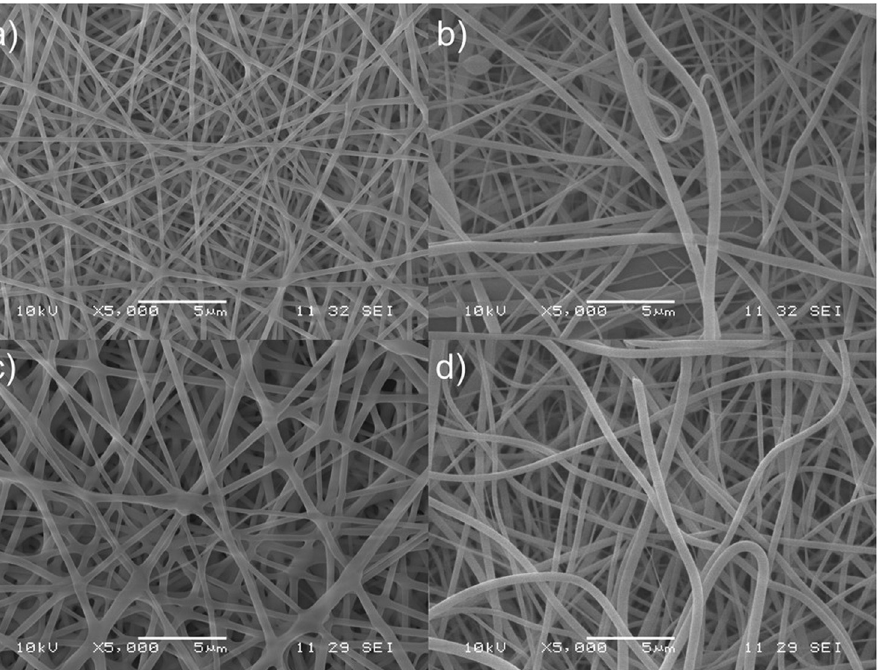
Figure 3: SEM micrographs of PVP/SC fi brous sca ff olds. ( a ) PVP/SC0 ( 5,000 ×) ; ( b ) PVP/SC1 ( 5,000 ×) ; ( c ) PVP/SC2 ( 5,000 ×) ; and ( d ) PVP/SC3 ( 5,000 ×)